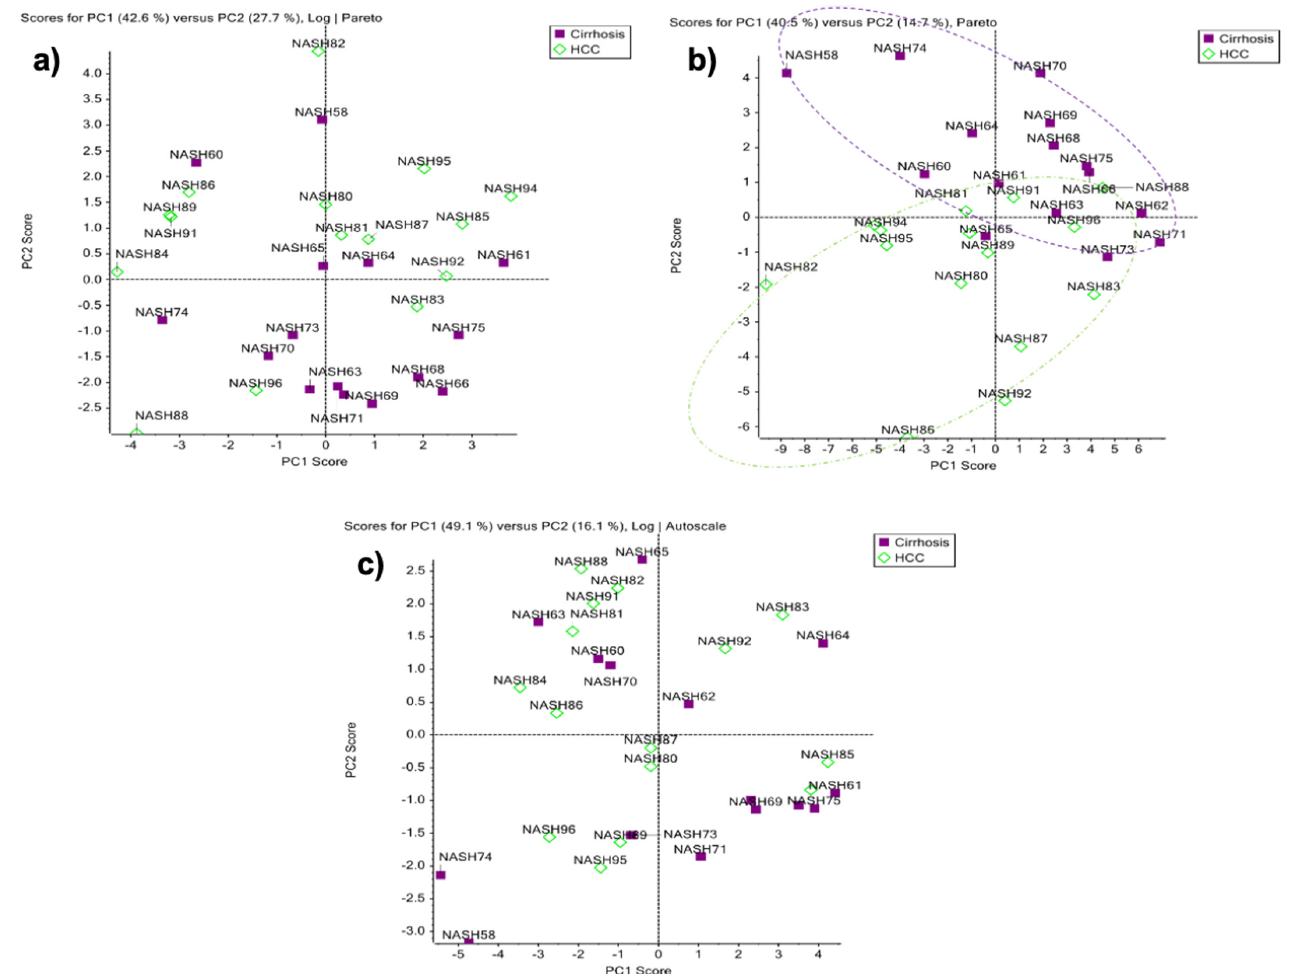
Figure 4. PCA plots for the glycosylation sites derived from human serum haptoglobin from patients with cirrhosis and HCC. ( a ) MVSHHN 184 LTTGATLINE; ( b ) NLFLN 207 HSE; and ( c ) VVLHPN 241 YSQVDIGLIK.